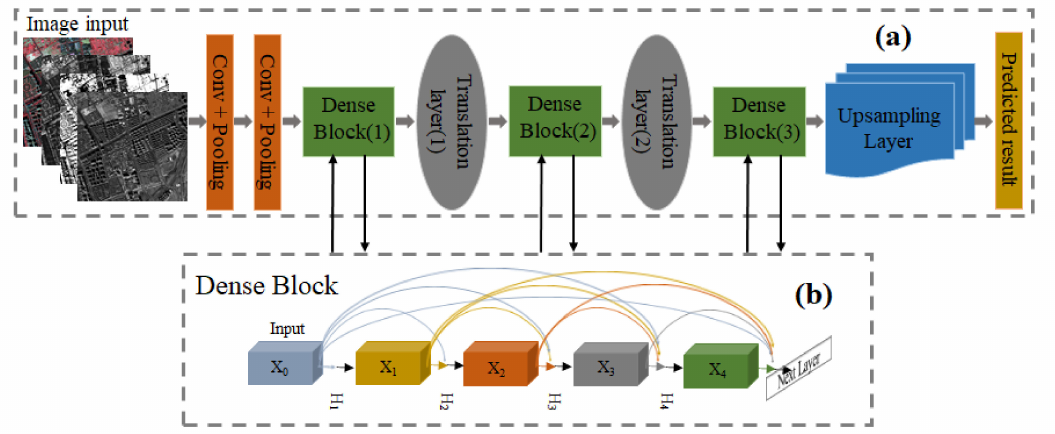
Figure 4. The improved DenseNet structure composed of three dense blocks: ( a ) the complete structure and ( b ) the Dense Block composed of five feature map